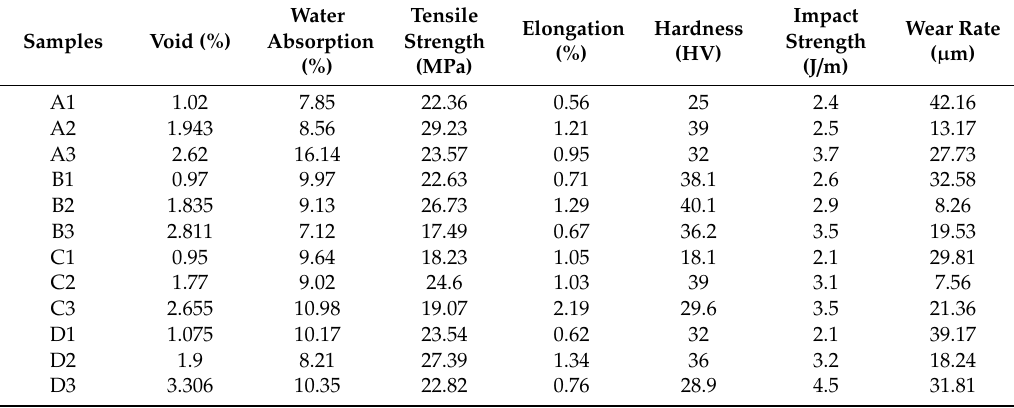
Table 5. Decision